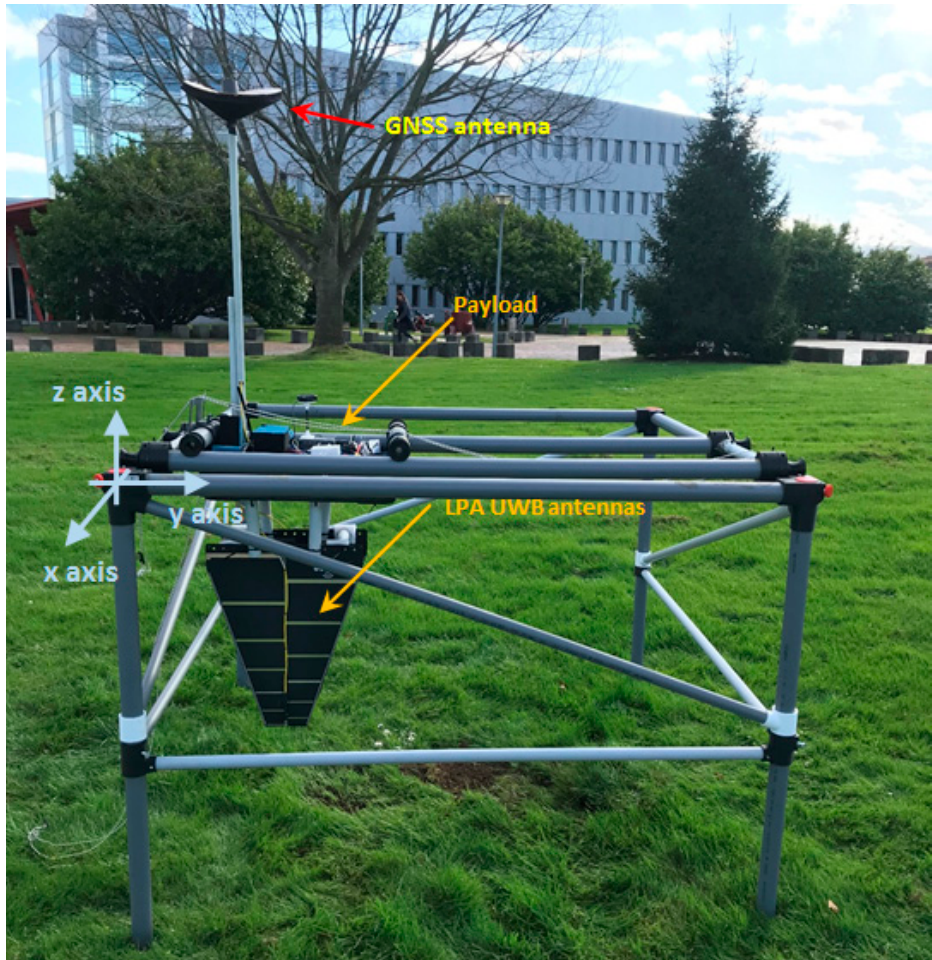
Figure 13. Picture of the portable air-launched GPR measurement with the Log-Periodic Antennas (LPA) antennas.